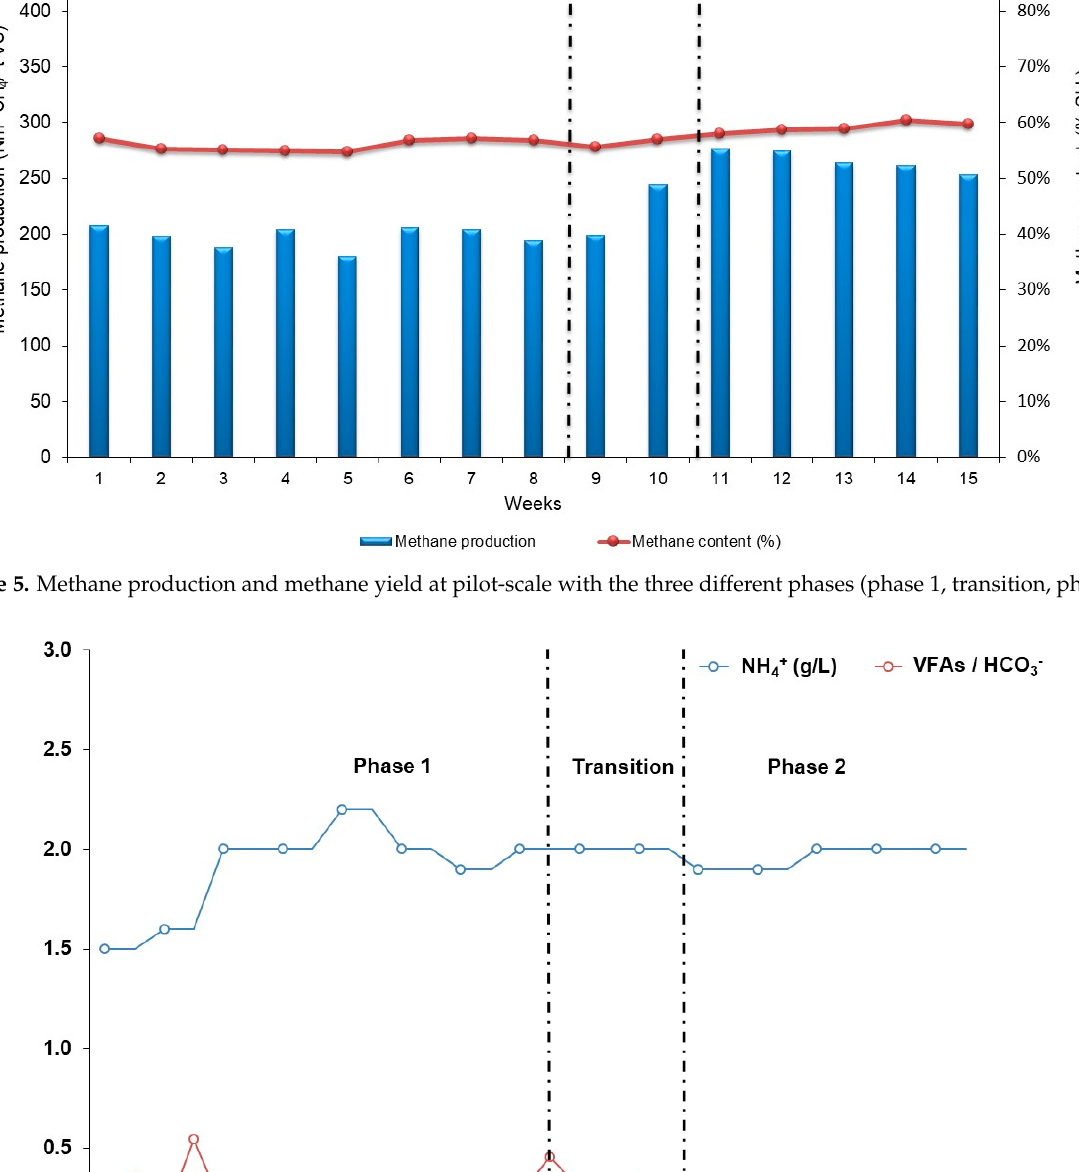
Figure 6. Ammonium (NH 4+ ) content and VFAs/HCO 3 − ratio during the different phases of the continuous pilot assay.